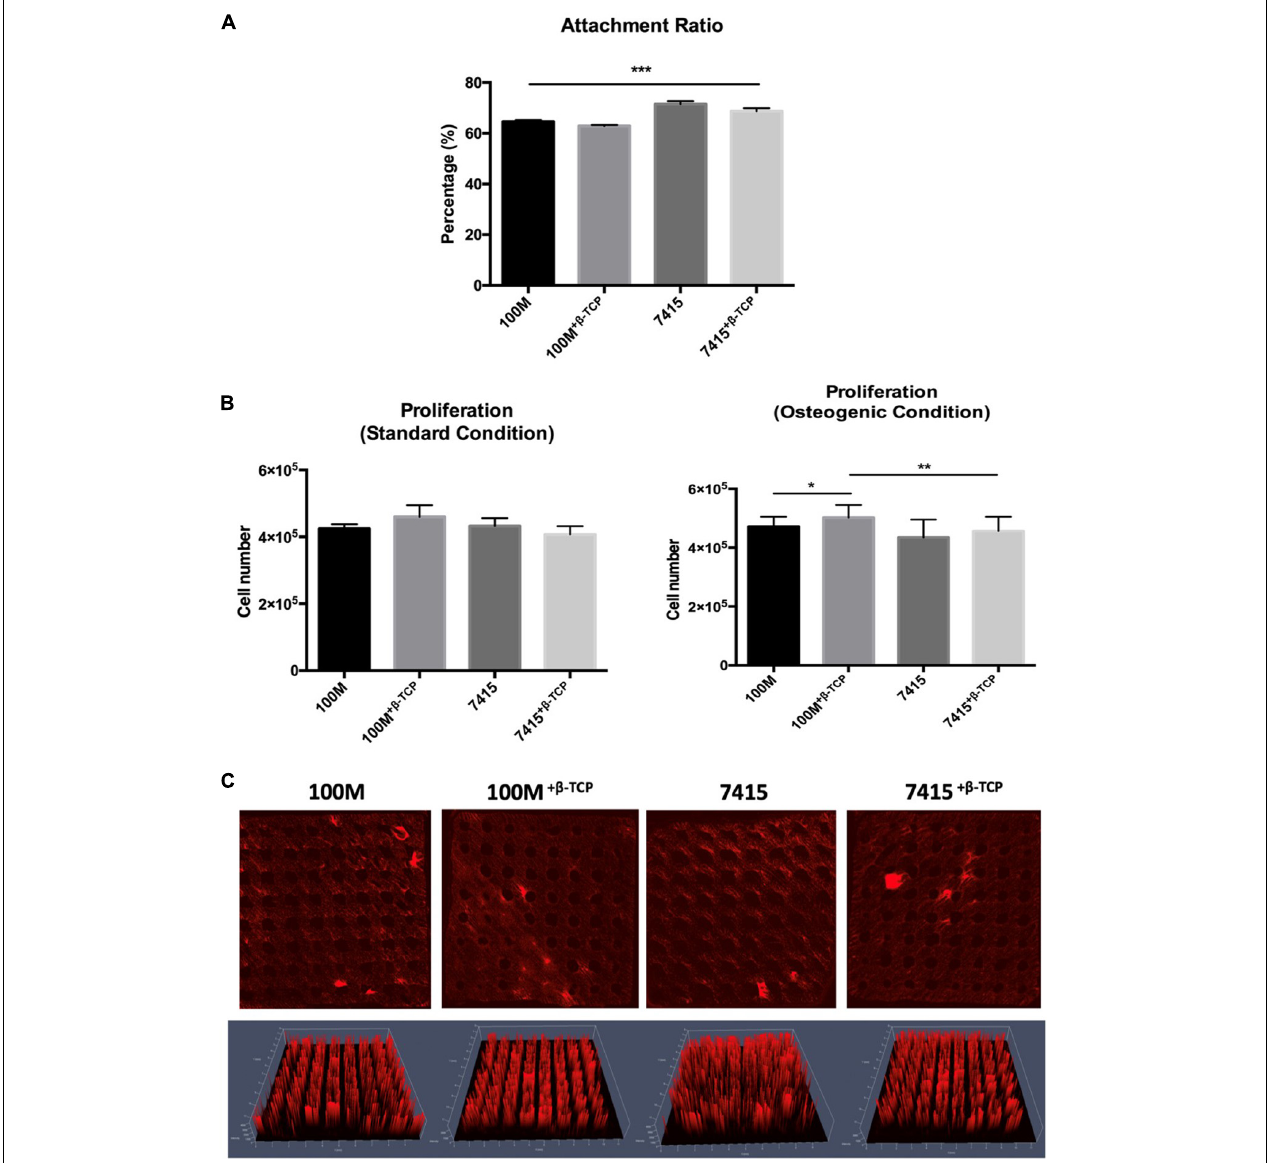
FIGURE 5 | Quantification of DNA and cell distribution. (A) Graph represents the attachment ratio quantifications of cell-seeded into each scaffold ( n = 3 in triplicate), error bars represent ± SD, and *** P -value < 0.001. (B) Proliferation graph present number of cells in each scaffold after 21 days in standard and osteogenic culture ( n = 3), error bars represent ± SD, and * P -value < 0.05, ** P -value < 0.01, *** P -value < 0.001. (C) Representative maximum intensity projection images showing scaffolds seeded with labeled cells after 1 week in osteogenic culture using confocal microscopy. Accordingly, 2.5D rendering images using (Zeiss Zen software) presenting the middle of the scaffold (2 mm Z -axis) ( n =